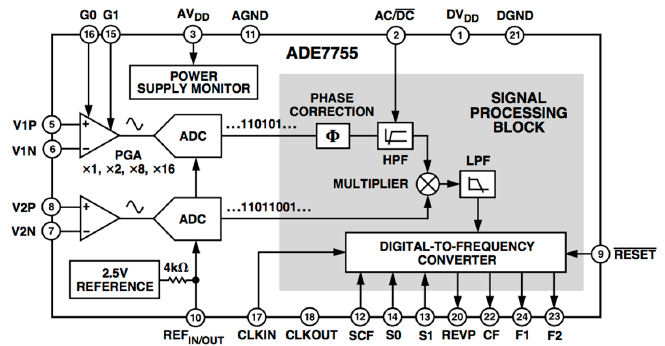
Figure 6. Internal block diagram of the ADE7755 active power processor [35].